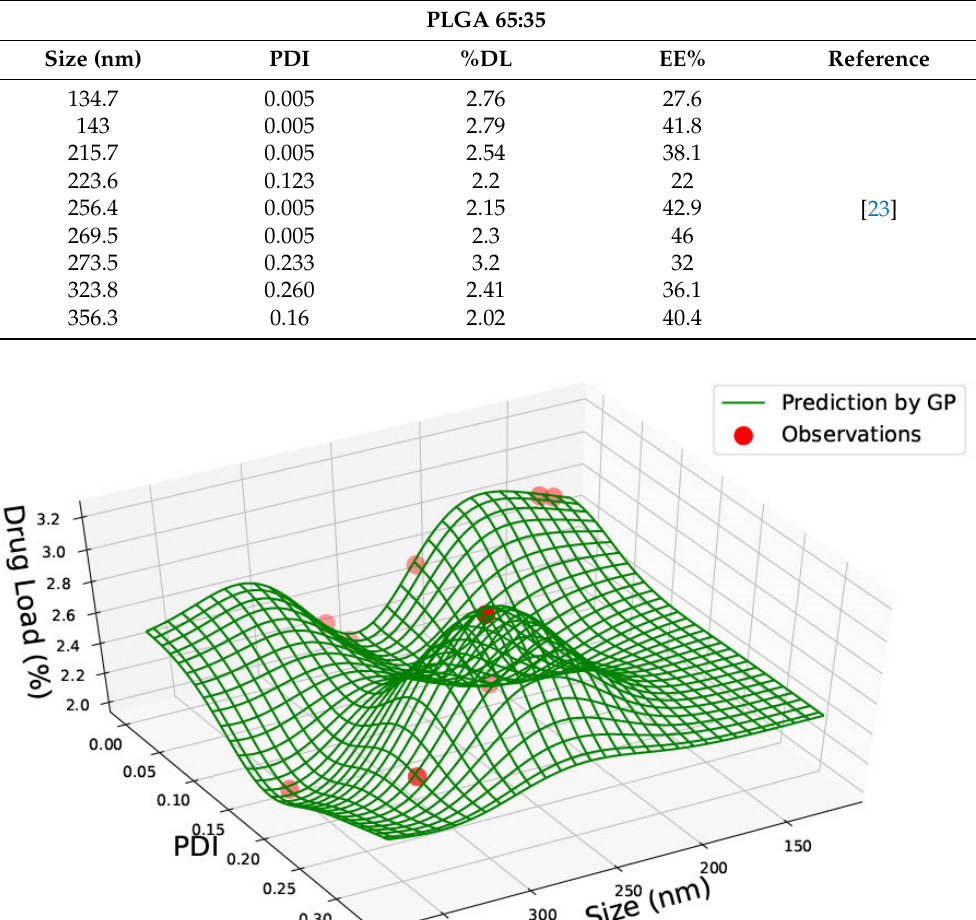
Figure 4. PLGA 65:35—graph with size (nm), Polydispersity Index (PDI) and Drug Load (%DL). Figure 4 represents graphs with size, PDI and drug load. Similar to PLGA 50:50, no correlation between the three categories can be seen. The data is scarcely distributed along the plot; however, the predictions exhibit that the highest drug load of 2.8% can be achieved with smaller nanoparticles (approximately 150 nm) and low PDI (between 0– 0.05). The drug load is slightly high (2.2%) for a nanomaterial size of approximately 200 nm and a PDI of 0.15. However, the drug load is seen to be lowest (below 2%) at a nano- particle size of about 350 nm and PDI of roughly 0.15, suggesting that drug load is not dependent on nanomaterial size or PDI.